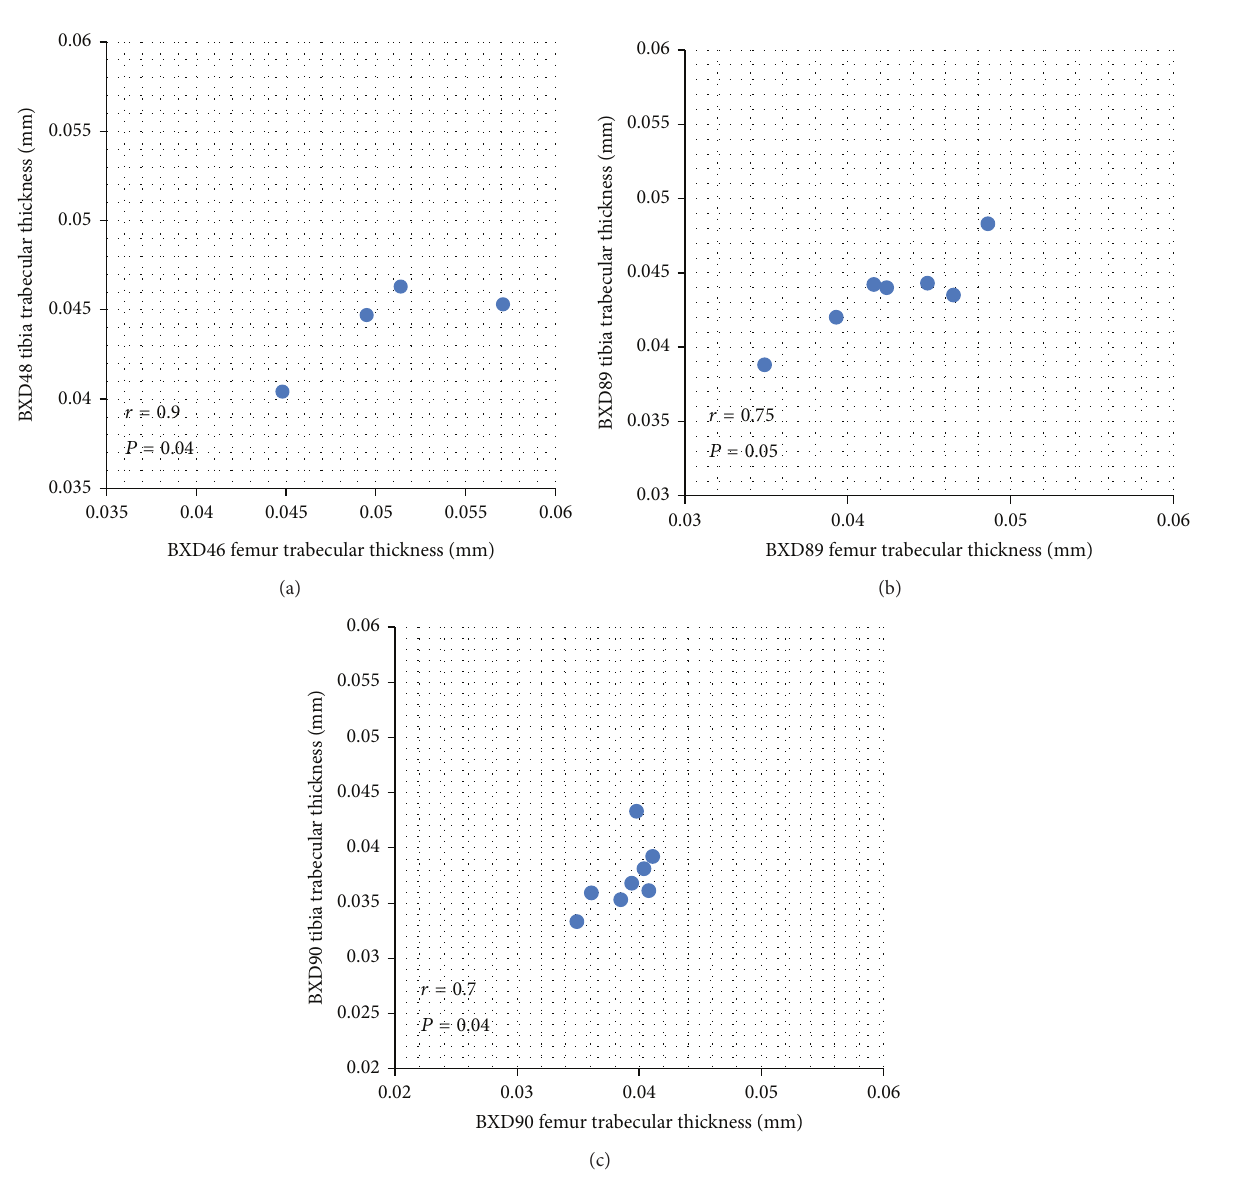
Figure 1: Spearman’s rank correlations in trabecular thickness showed strong positive association between femur and tibia. (a) RI Strain BXD48 ( 𝑟 = 0.9 , 𝑃 = 0.04 ); (b) RI Strain BXD89 ( 𝑟 = 0.75 , 𝑃 = 0.05 ); (c) RI Strain BXD90 ( 𝑟 = 0.7 , 𝑃 = 0.04